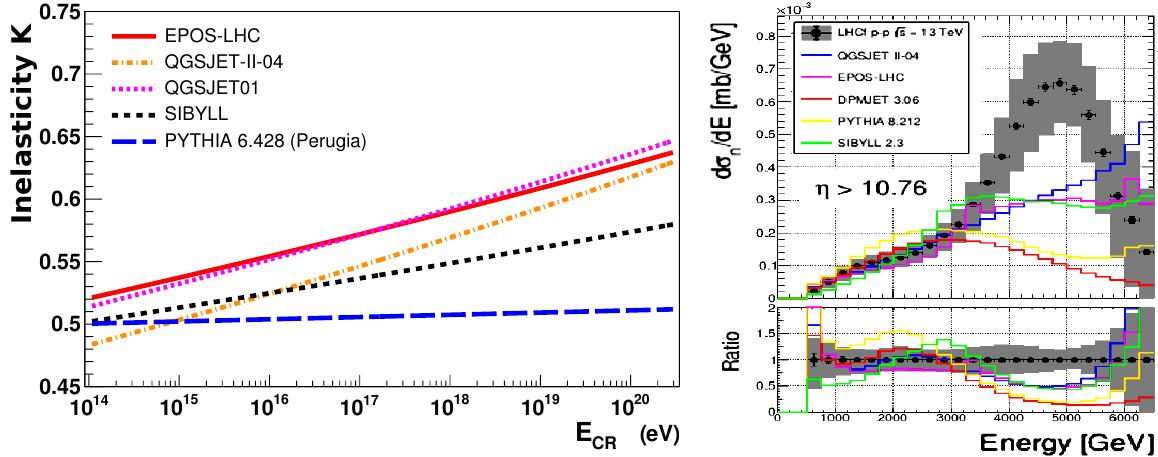
Figure 3. Left: MC predictions for the p-p inelasticity as a function of CR energy [31]. Right: Di ff erential neutron cross section √ s = 13 TeV compared to MC predictions measured by the LHCf experiment at η > 10 . 76 in p-p at